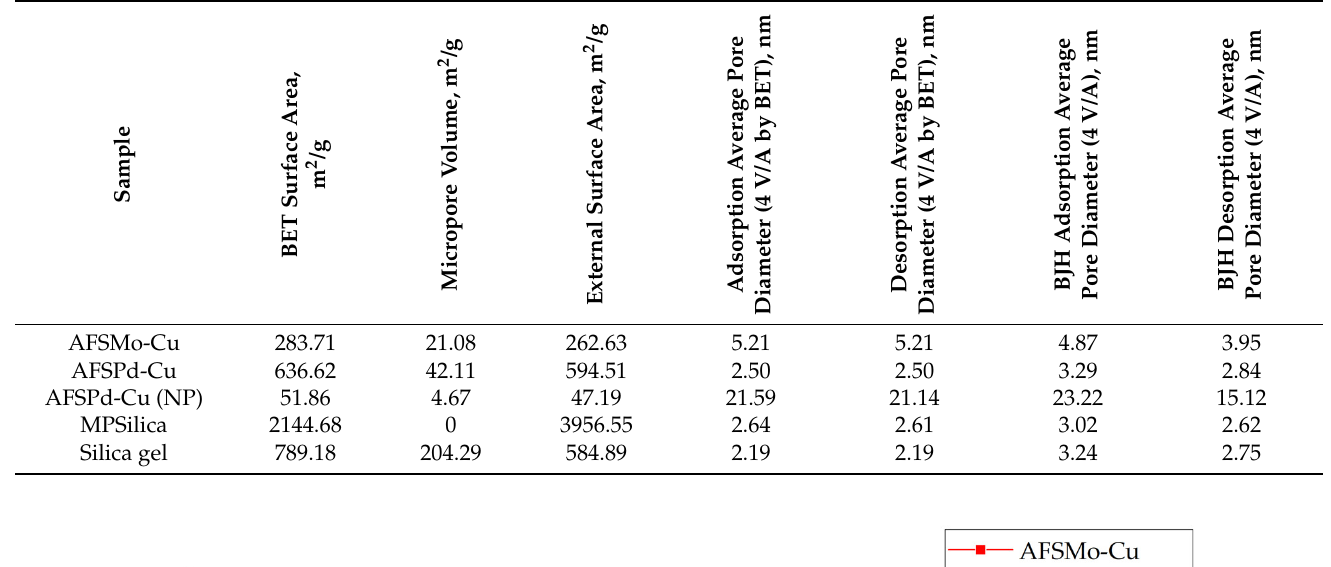
Table 2. Summary of BET + BJH analysis results.